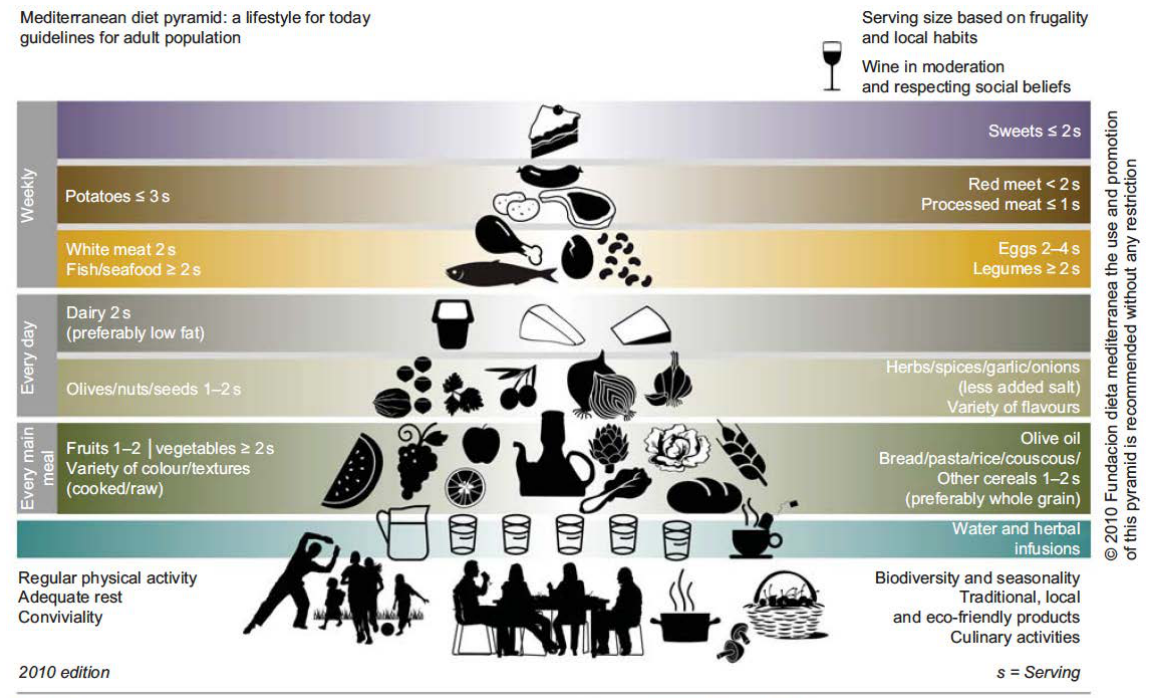
Figure 1. Principal components of the Mediterranean diet as represented by the diet pyramid. Intake frequency is shown, represented for each main food group. One or two servings of nuts are recommended daily. Reproduced by permission of Dr. L. Serra-Majem [22].